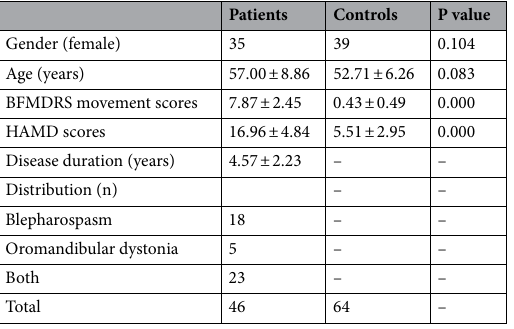
Table 1. Clinical data for Meige syndrome patients and control subjects.